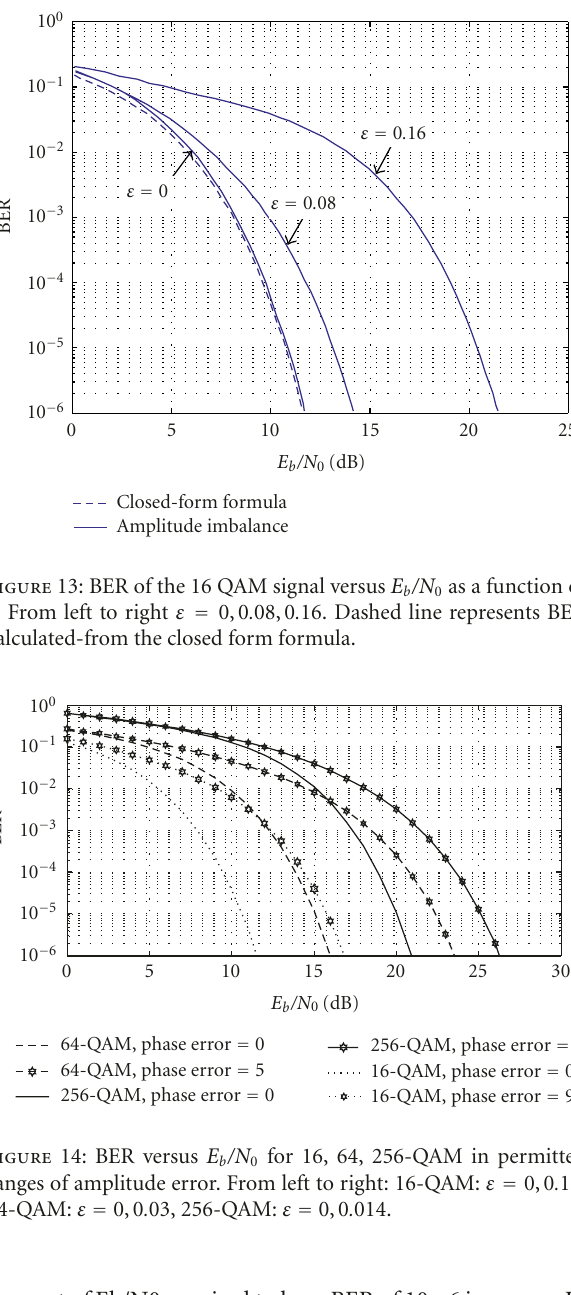
amount of Eb/N0 required to have BER of 10e-6 increases.